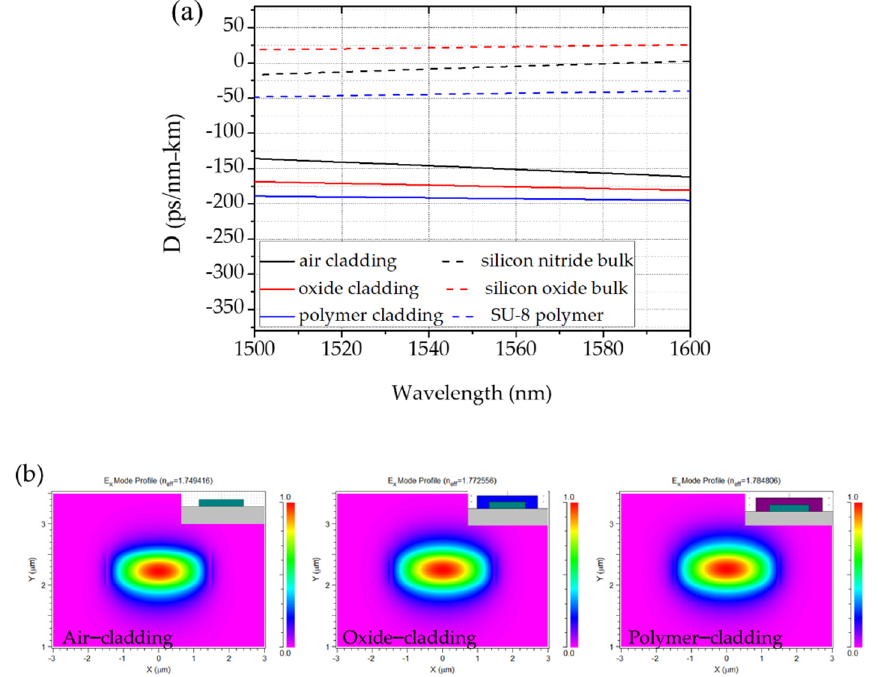
Figure 2. ( a ) Waveguide dispersion of air-, oxide-, and SU-8 polymer-cladding with 500 nm height and 3 µ m width (solid lines) and material dispersion of silicon nitride, silicon oxide, and SU-8 polymer (dashed lines). ( b ) Field distribution of the waveguide without cladding layer, with oxide-cladding layer, and with polymer-cladding layer.